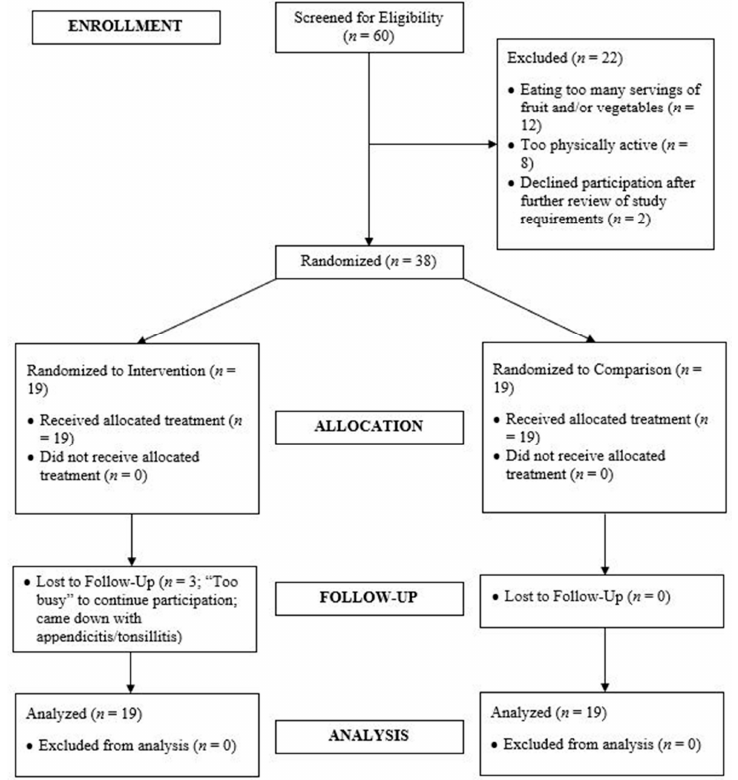
Figure 1. Consolidated Standards of Reporting Trials (CONSORT) Participant Flow Diagram.